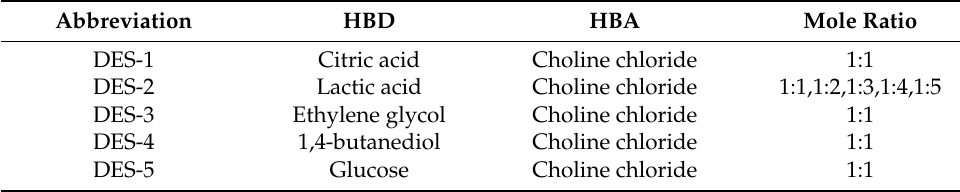
Table 1. Different types of DESs (deep eutectic solvents) studied.